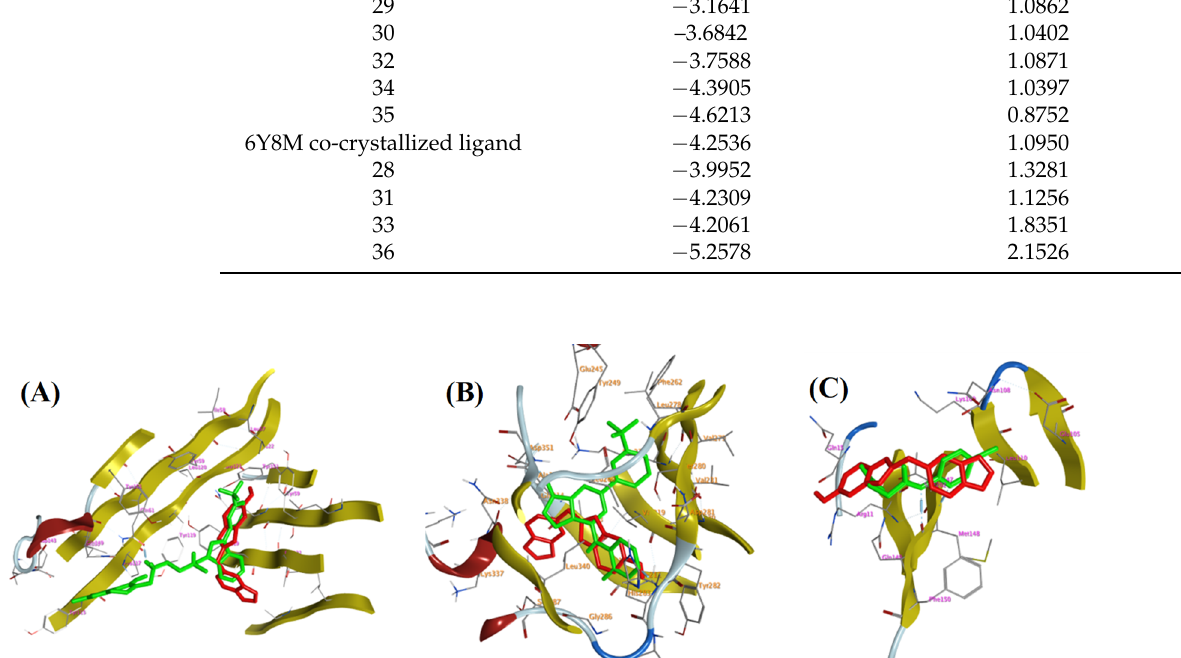
Table 6. Binding free energy score (S; kcal/mol) with binding interactions for different co-crystal- lized ligands and compound 28 within TNF α (PDB ID: 2AZ5); TGFBR1 kinase (PDB ID: 6B8Y); and IL-1 β (PDB ID: 6Y8M) binding sites.